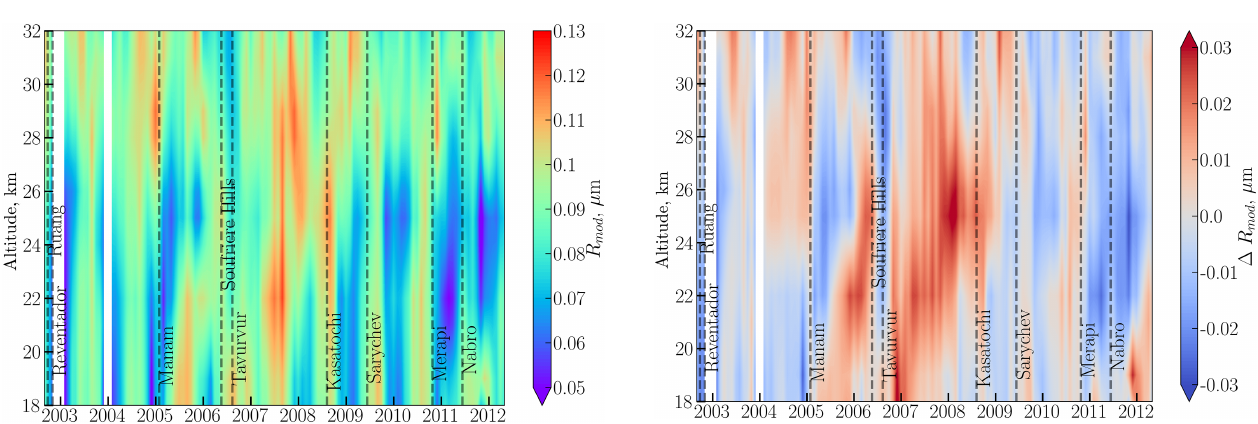
Figure 9. Monthly zonal mean values of R mod retrieved from SCIAMACHY limb data in the tropics (20 ◦ N–20 ◦ S).